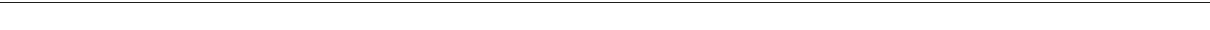
Fig. 1 Sex differences in placental trophoblast and fetal hypothalamic gene expression are mediated by placental Ogt copy number. a , b Scatterplots of mRNAs with sex differences in trophoblast cell-speci fi c expression at E12.5 (4560 genes, FDR adjusted p < 0.05). a Scatterplot comparing sex differences (black circles) with differences between X wt /X wt and X ogt − /X wt females (red circles). Trophoblast gene expression patterns with sex differences (black circles) are mimicked by Ogt reduction in female trophoblasts (red circles). b Scatterplot comparing trophoblast sex differences (black circles) with differences between X ogt − /X wt and X wt /Y (red circles). Female patterns of gene expression are masculinized by Ogt reduction in female trophoblasts. c Heatmap of mRNA with sex differences in expression in X wt /X wt , X ogt − /X wt , X wt /Y trophoblasts. Expression patterns of trophoblast genes (columns) with sex differences are mimicked by Ogt reduction in female trophoblasts (individual placentas = rows). Z -scores plotted across individuals for each gene. d Venn diagram displaying the number of differentially expressed genes in X wt /Y vs. X wt /X wt ( n = 4560 genes), X ogt − /X wt vs. X wt /Y ( n = 251 genes), and X ogt − /X wt vs. X wt /X wt ( n = 2197 genes) trophoblasts and the number of differentially expressed genes common in these groups. e A total of 1094 of the 2609 trophoblast genes enriched in X wt /X wt relative to X wt /Y were signi fi cantly decreased by trophoblast-speci fi c Ogt reduction (X ogt − /X wt ). f A total of 432 trophoblast genes with increased relative expression in X wt /Y were enhanced in X ogt − /X wt relative to X wt /X wt . g Only 7 of the 2609 genes with X wt / X wt -biased sex differences in expression were upregulated by trophoblast-speci fi c Ogt reduction (X ogt − /X wt ). h A total of 4 of the 1951 X wt /Y-biased genes with basal sex differences were downregulated in X ogt − /X wt trophoblasts. N = 3 X wt /Y, n = 4 X wt /X wt , and n = 5 X ogt − /X wt placentas, from fi ve individual litters with n = 1/litter/group to control for litter